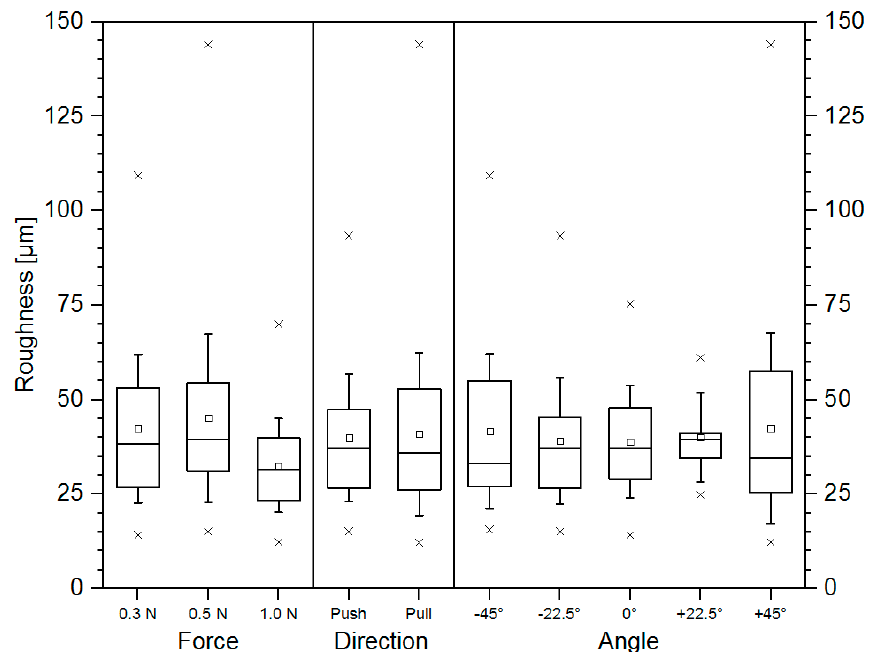
Figure 4. Roughness values obtained during the scratch performances, unfiltered and classified into their respective configuration (force, direction, and angle), displayed as a box plot (symbols: □ = mean value, x = min/max values). It is possible to visually identify operational modes that have enabled reliable scratch borders with a low border roughness.